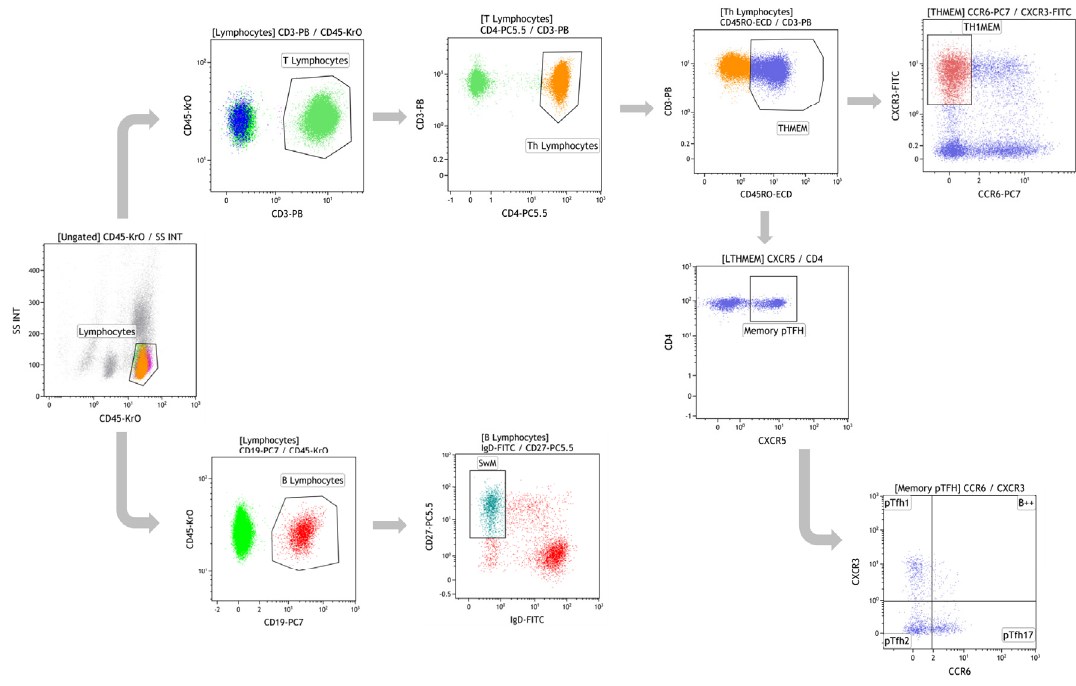
Table 1. Phenotypic characterization of the T and B cell subsets.